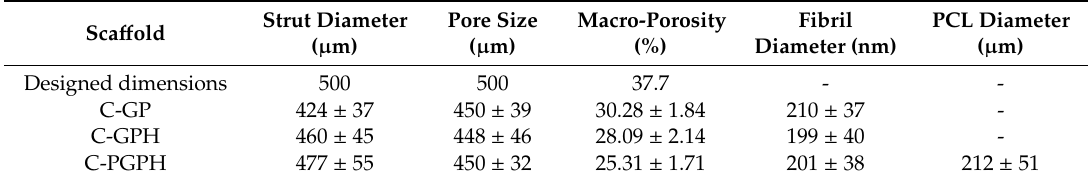
Figure 3. ( a ) Optical and SEM images of the fabricated sca ff olds (C-GP, C-GPH and C-PGPH). ( b ) Measured strut and pore size of each sca ff old. ( c ) Optical images showing strut changes after dissolving the GPH-laden shell region in 37 ◦ C distilled water. Table 2. Strut diameter, pore size, macro-porosity, collagen fibril size, PCL diameter in the core region and shell thickness of the fabricated sca ff